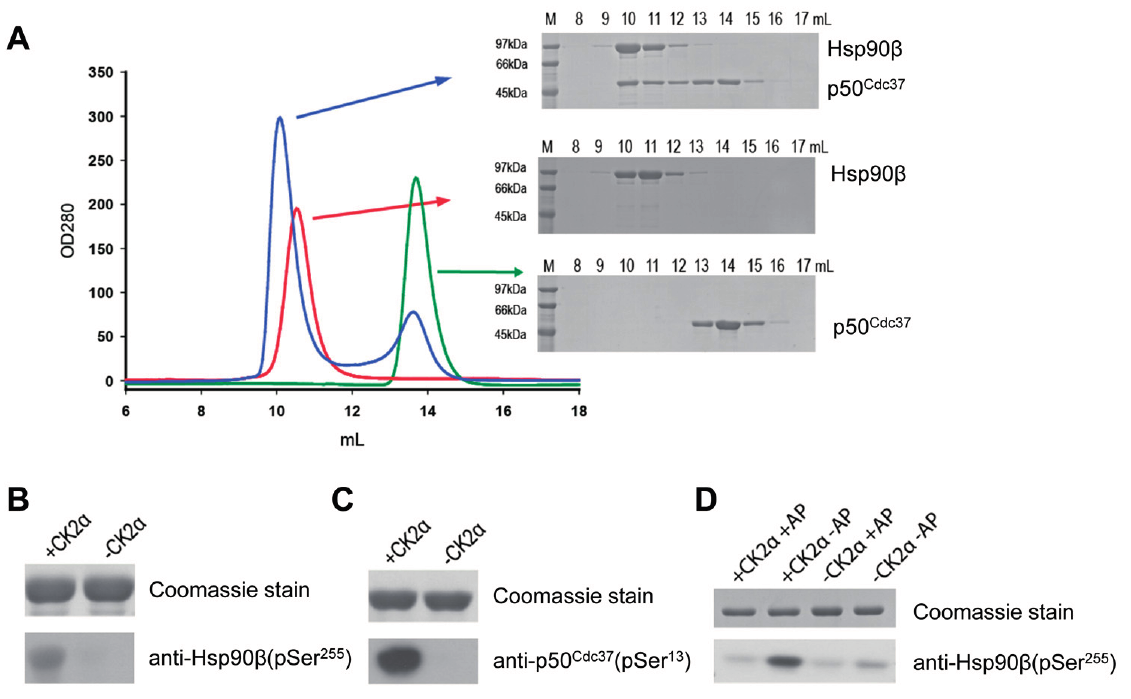
Figure 1. In vitro reconstitution of the human full-length Hsp90 β :p50 Cdc37 complex and phosphorylation by CK2 α . ( A ) Elution profiles and corresponding SDS-PAGE for analytical gel filtration experiments showing complex formation (blue) upon incubation of free Hsp90 β (red) with free p50 Cdc37 (green). ( B ) Coomassie-stained SDS-PAGE and Western blot analysis of purified Hsp90 β in the presence and absence of CK2 α and ATP using anti-Hsp90 β (pSer 255 ); ( C ) Coomassie-stained SDS-PAGE and Western blot analysis of purified p50 Cdc37 in the presence and absence of CK2 α and ATP using anti-p50 Cdc37 (pSer 13 ); ( D ) Phosphorylation states of Ser255 in Hsp90 β upon phosphorylation by CK2 α and dephosphorylation by alkaline phosphatase